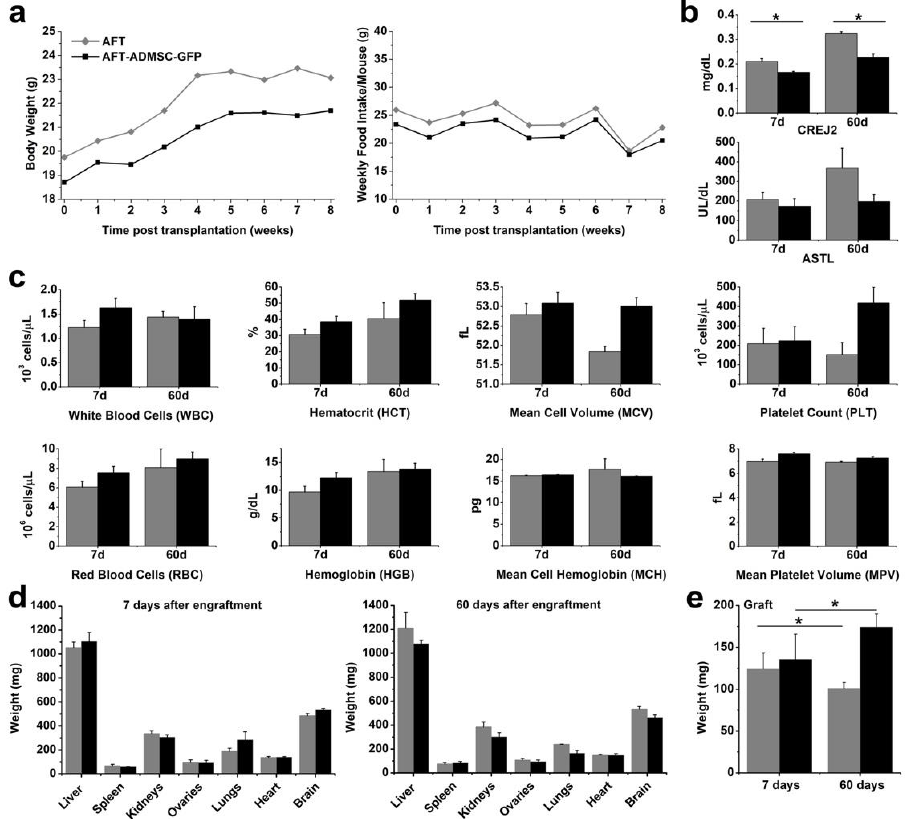
Figure 3. Xenotransplantation did not affect the NOD SCID mice’s health: ( a ) the average weight of the mice (left graph) and food intake (right graph) were similar between the two groups; ( b ) serological CREJ2 increased in the AFT group compared to the AFT-ADMSC-GFP group, while the ASTL levels were similar; ( c ) the hematological parameter results were similar for both groups; ( d ) the organ weight results were comparable between the AFT and AFT-ADMSC-GFP groups at 7 days (graph left) and at 60 days (right graph); ( e ) the grafts had similar weights at 7 days post-transplantation, while at 60 days, AFT-ADMSC-GFP had a statistically significant increase compared to AFT. * p < 0.05, n = 7; grey = AFT group; black = AFT-ADMSC-GFP group.